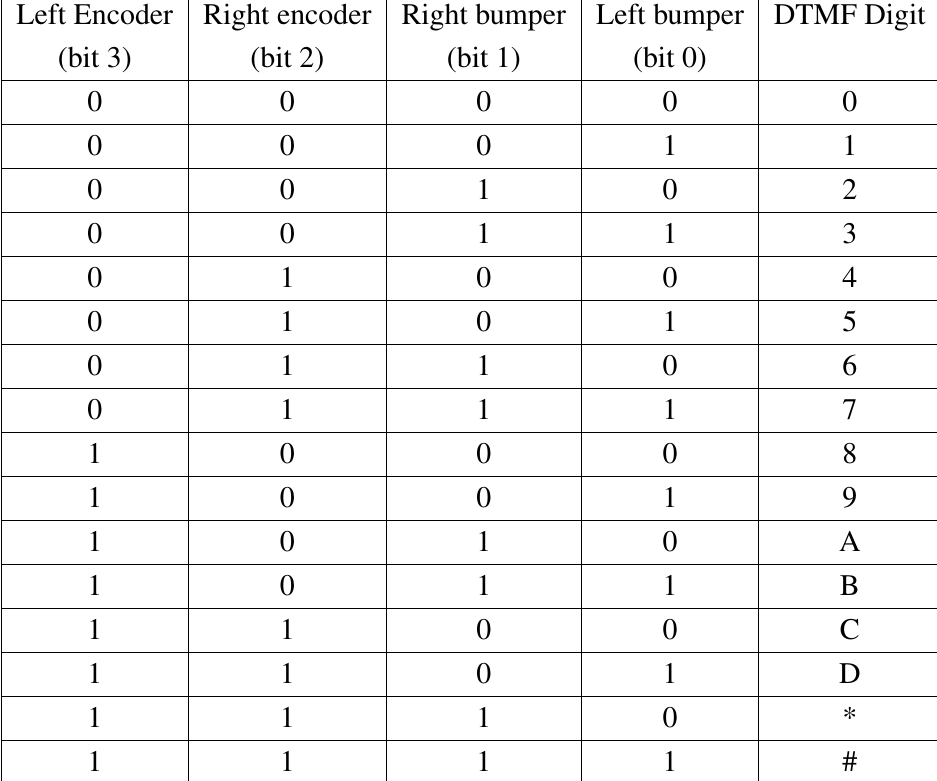
Table 3. Truth table used with 4 sensors input used in the case study